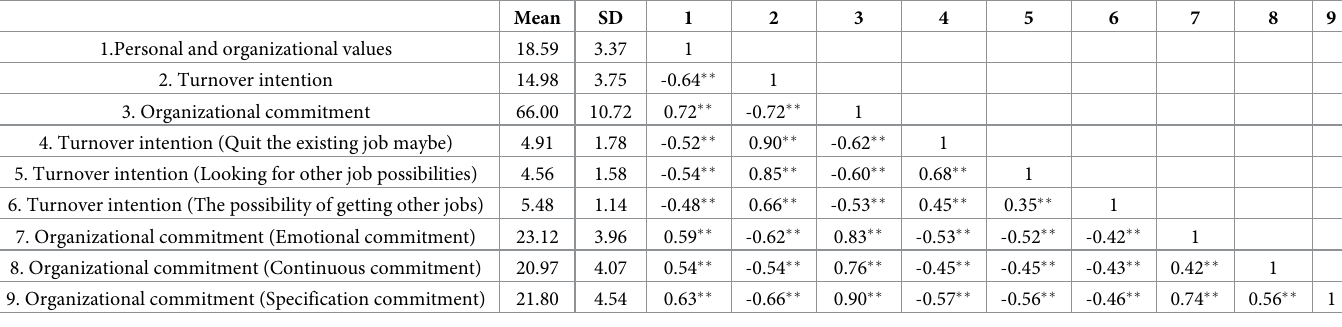
Table 2. Means, standard deviation (SD), and correlations of turnover intention, organizational commitment, and personal and organizational values.